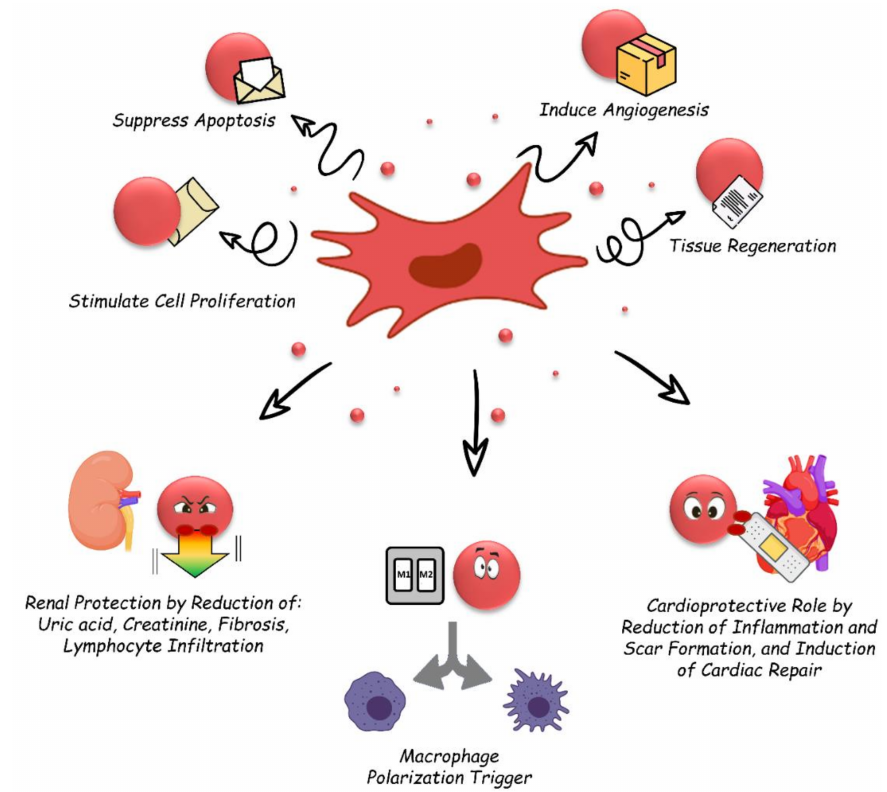
Figure 2. Therapeutic potential of stem cell derived-EVs. Schematic representation of the suggested effects of EVs in regenerative medicine, with particular attention on renal and cardio protection, and macrophages polarization. Table 1. Therapeutic application of stem cell-derived Extracellular Vesicles (EVs)